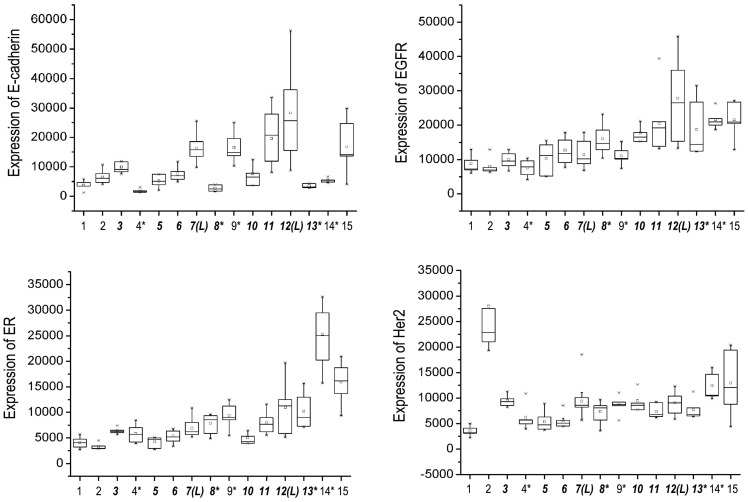
Intratumoral heterogeneity and variation amongst different patients in the expression of 4 exemplary proteins (E-cadherin, EGFR, ER, and HER2) assessed by reverse-phase-protein-arrays.Box plots are showing the median (line within the box), 25th and 75th percentiles, and whiskers are showing 1.5 times the interquartile range; the small box sign is showing the mean, and small cross signs show the maximum and minimum values. Italics (bold), all cases containing lymph node metastases; * invasive lobular cancers; (L), two largest primary tumors (7.9 and 8.0 cm diameter).